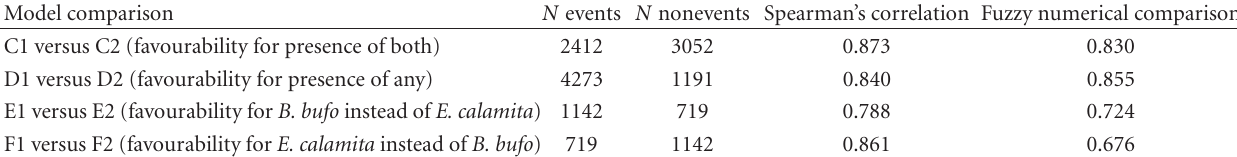
Table 2: Number of analysed presences and absences and measures of the overall similarity between the predictions produced by modelling combined species distribution data and by fuzzy logic operations between individual species models. For model abbreviations, please see Section 2. Spearman’s correlations (with Dutilleul’s correction for spatial autocorrelation) were all highly significant ( P < 0 . 001). Model